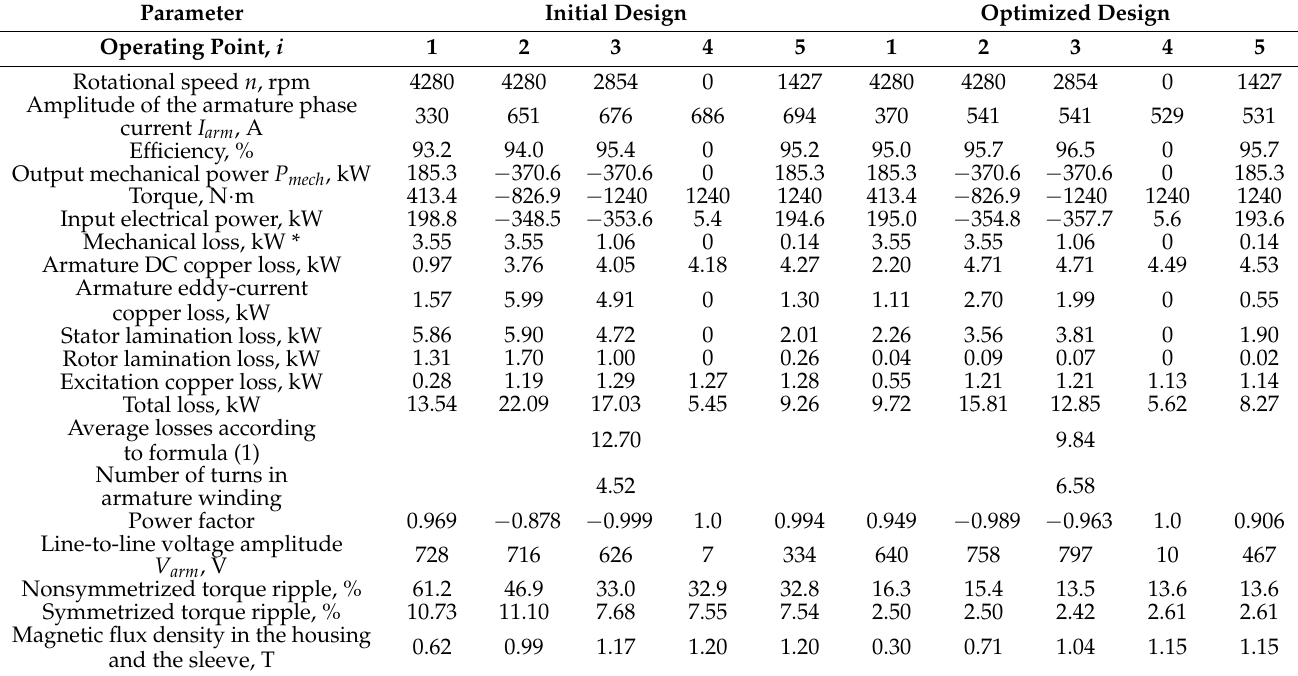
Table 5. Optimization